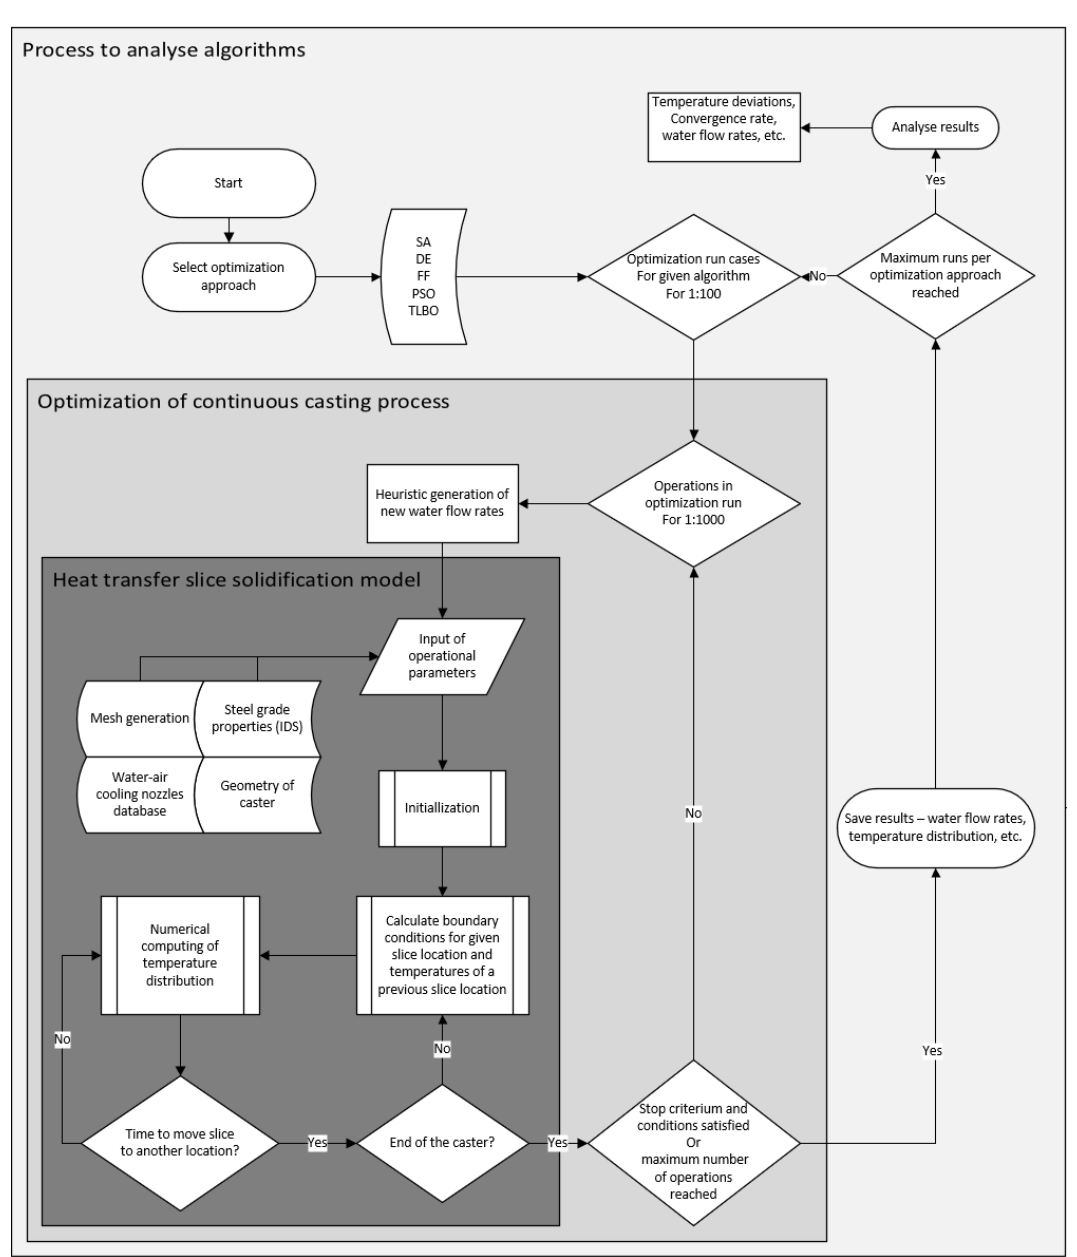
Figure 7. Flow block diagram representing the applied optimization process.